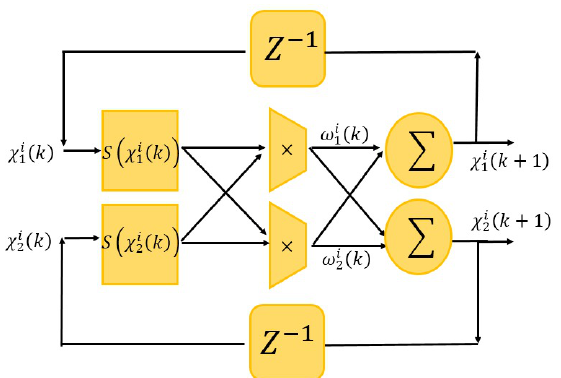
Figure 2. Neural identifier based on recurrent high-order neural network (RHONN)